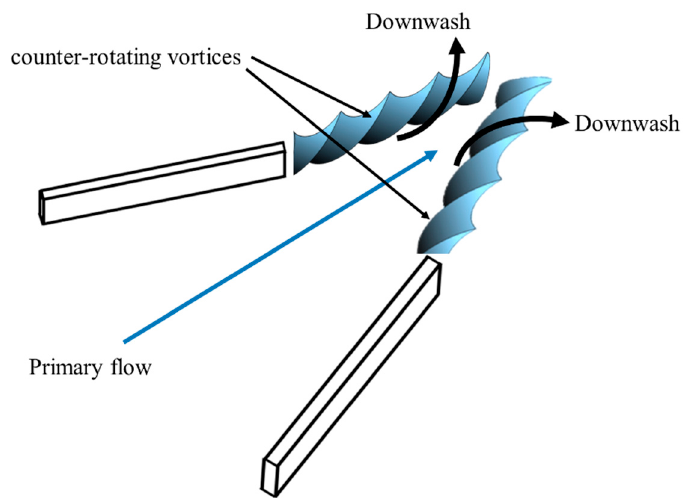
Figure 2. 3D flow structure of a CRV type MVG.